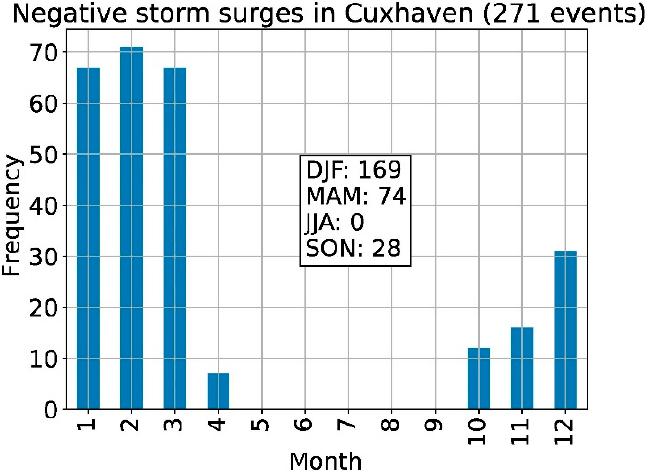
Figure 6. Monthly distribution of all 271 ELWs at the tide gauge Cuxhaven from 1950–2019.